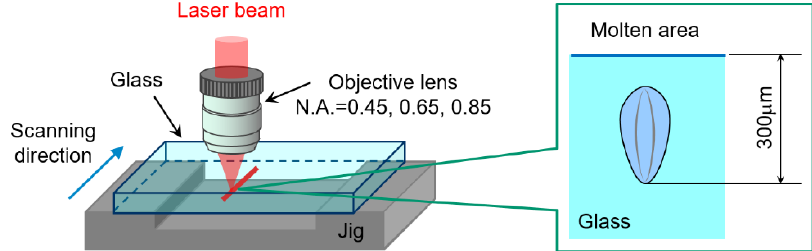
Appl. Sci. 2019 , 9 , x FOR PEER REVIEW Figure 2. Schematic illustration of laser irradiation setup in bead-on-plate welding experiment.